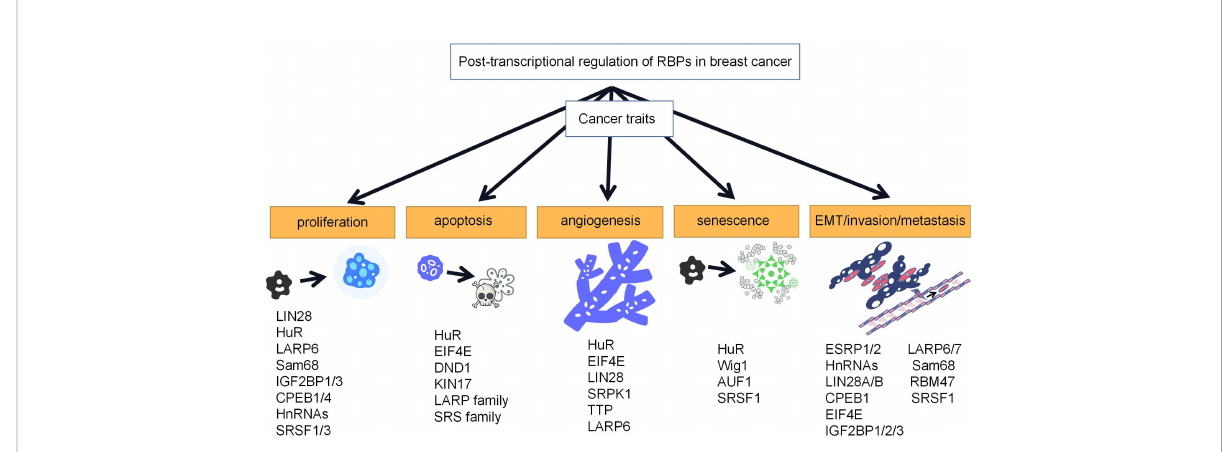
FIGURE 2 Roles of RBPs in breast cancer. RBPs play important roles in proliferation, apoptosis, angiogenesis, senescence, and EMT/invasion/metastasis of breast cancer. Representative RBPs for breast cancer traits are listed in the schematic